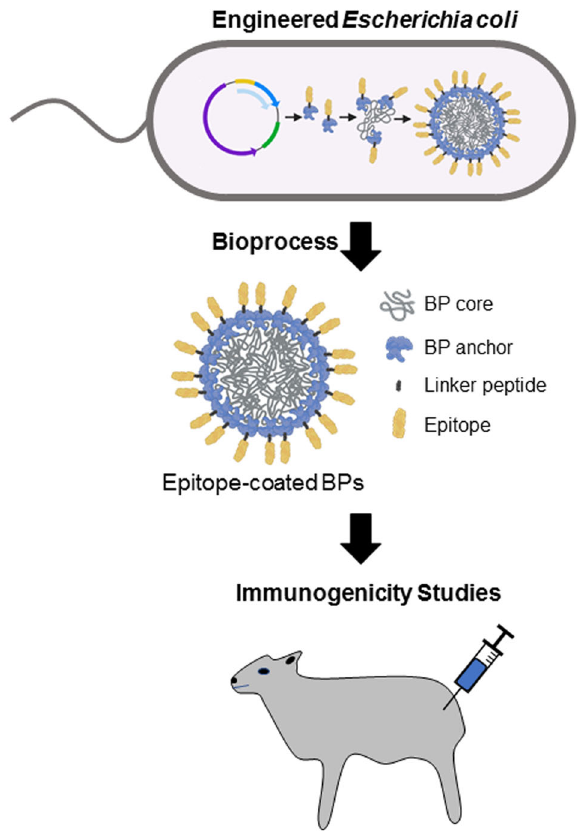
Fig. 1 Schematic of BP vaccine production and composition. An endotoxin-free production strain of E. coli, ClearColi BL21(DE3), was bioengineered to produce P. falciparum CSP epitope-coated BPs in one step. Immunogenicity of epitope-coated BPs was analysed in the sheep